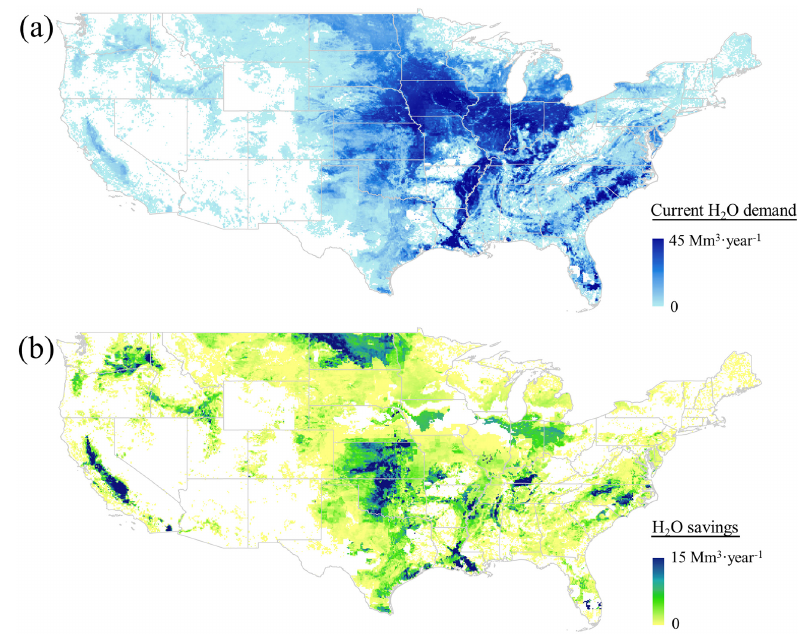
Figure 2. Reduction in consumptive water use from redistributing crops. ( a ) Current water demand for major crops in the United States and ( b ) potential water savings from optimizing crop distributions.